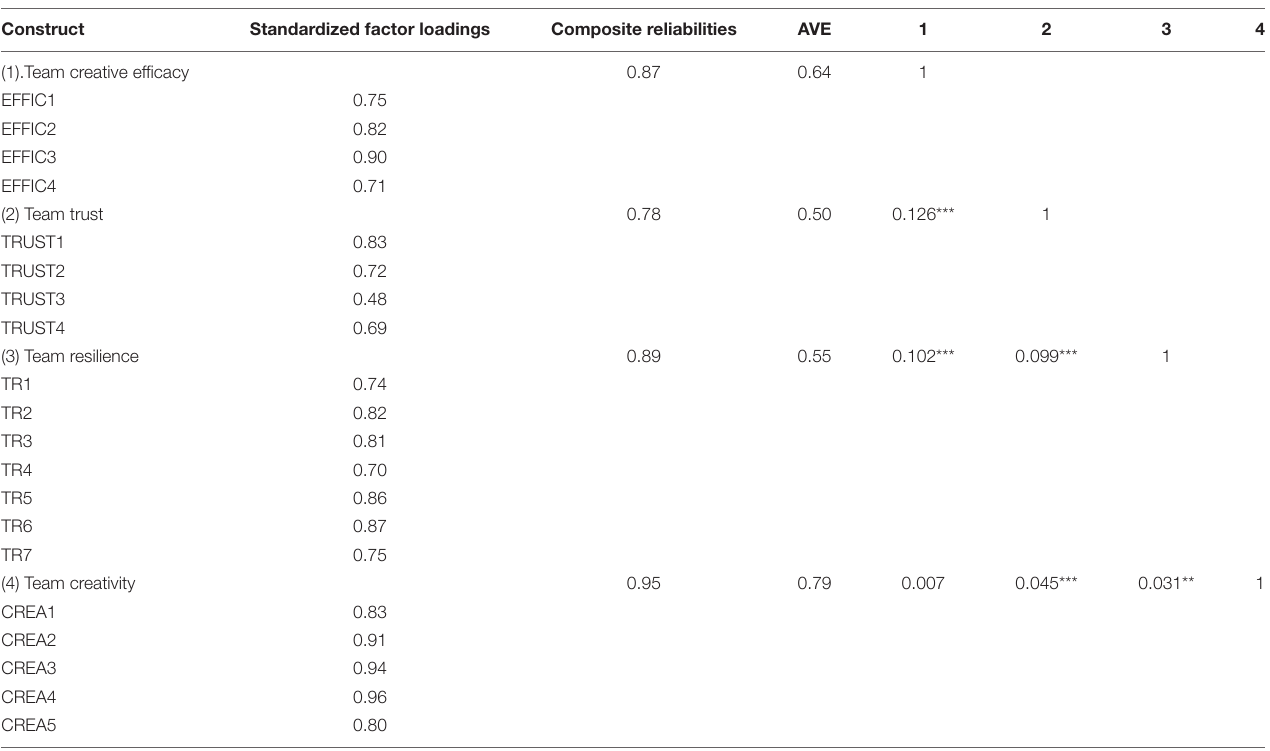
TABLE 2 | Results of confirmatory factor analysis and correlations of constructs.